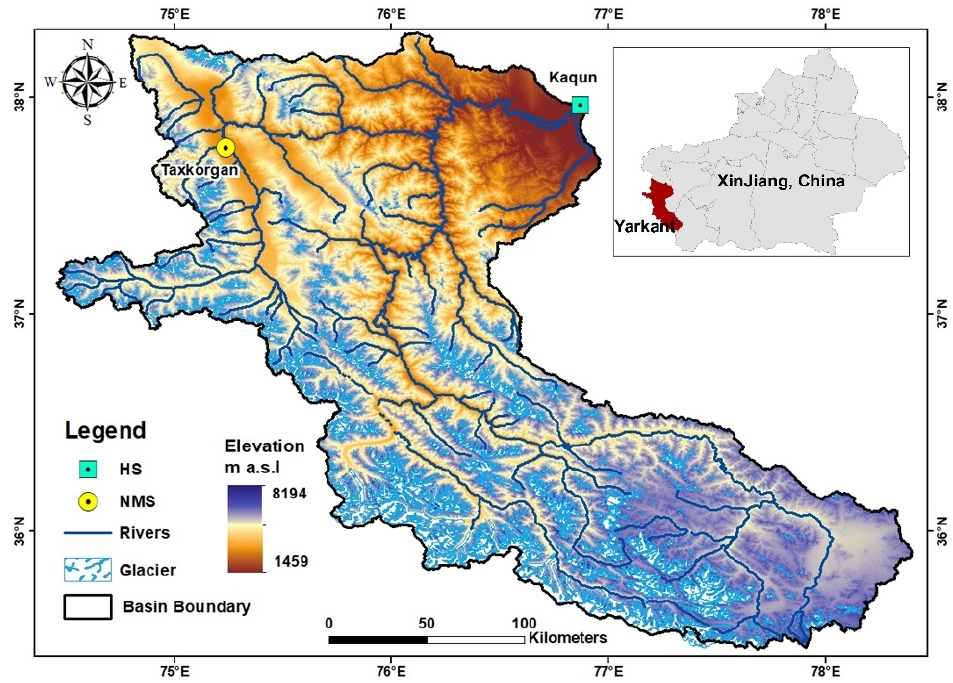
Figure 1. Geological position of the Yarkant River and station distribution, where NMS is the national meteorological station (Taxkorgan) and HS is the national hydrological station (Kaqun